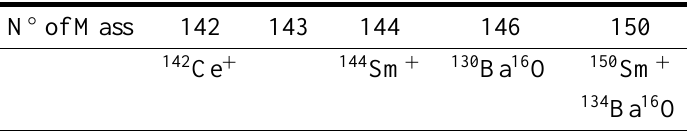
Mass interferences in Nd isotopic